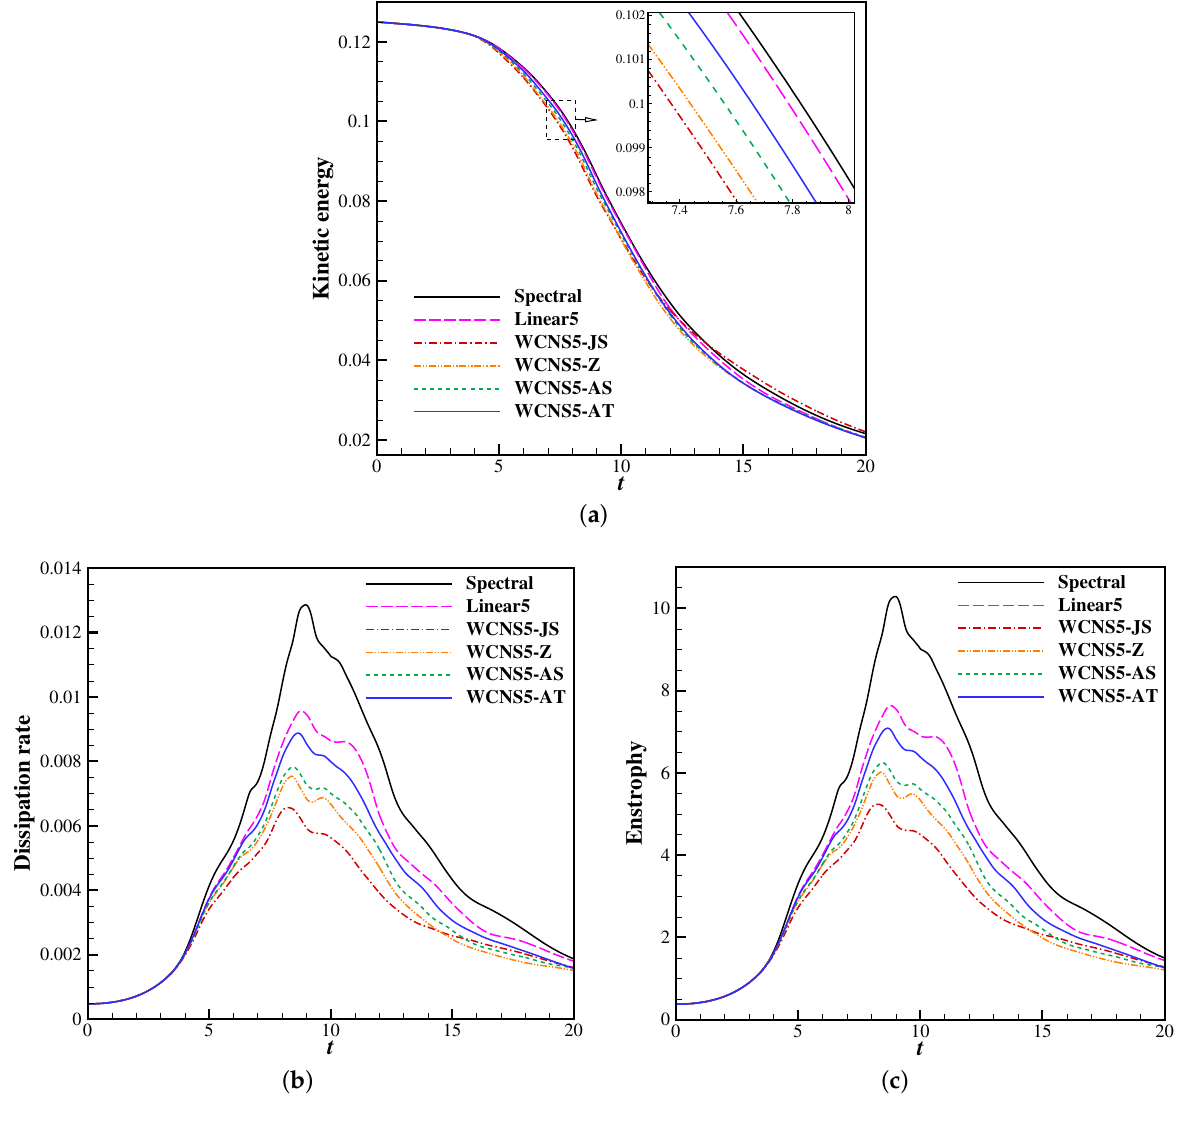
Figure 21. Temporal evolutions of the results for viscous Taylor-Green vortex with 257 × 257 × 257 grid points: ( a ) kinetic energy; ( b ) kinetic energy dissipation rate; ( c )